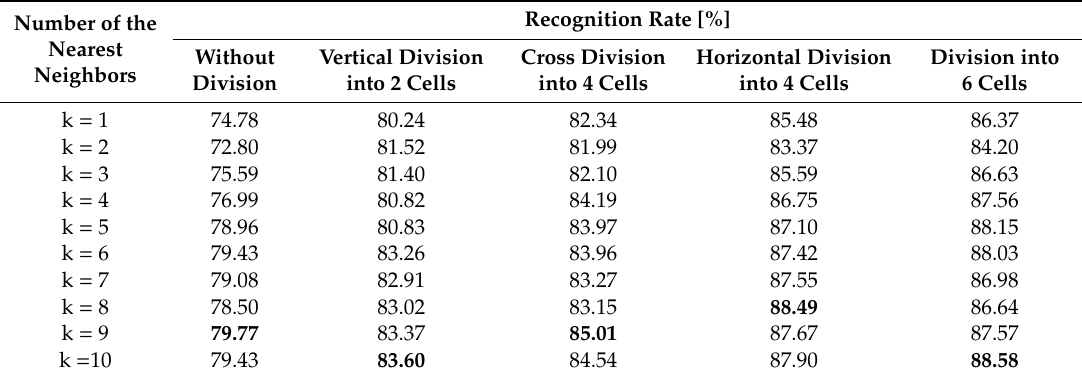
Table 2. Comparison of the recognition rates for the UTD-MHAD set, k-NN with DTW, and LOSO eight-fold cross-validation; the best values are marked in bold.